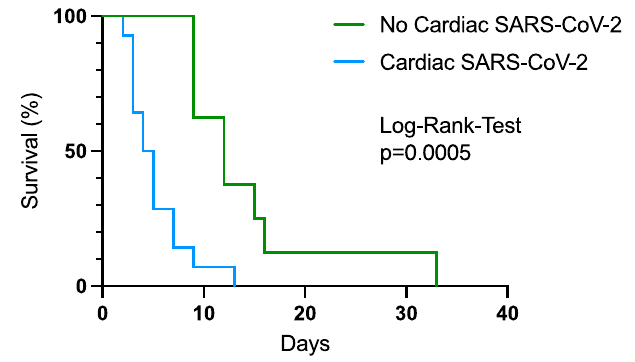
Fig. 5 Short-term survival of 23 COVID-19 fatalities. Cardiac SARS-CoV-2 infection (blue line, n = 12) correlated with signi fi cantly shorter survival (Log-Rank-Test p = 0.005) compared to patients without cardiac viral load (green line, n =